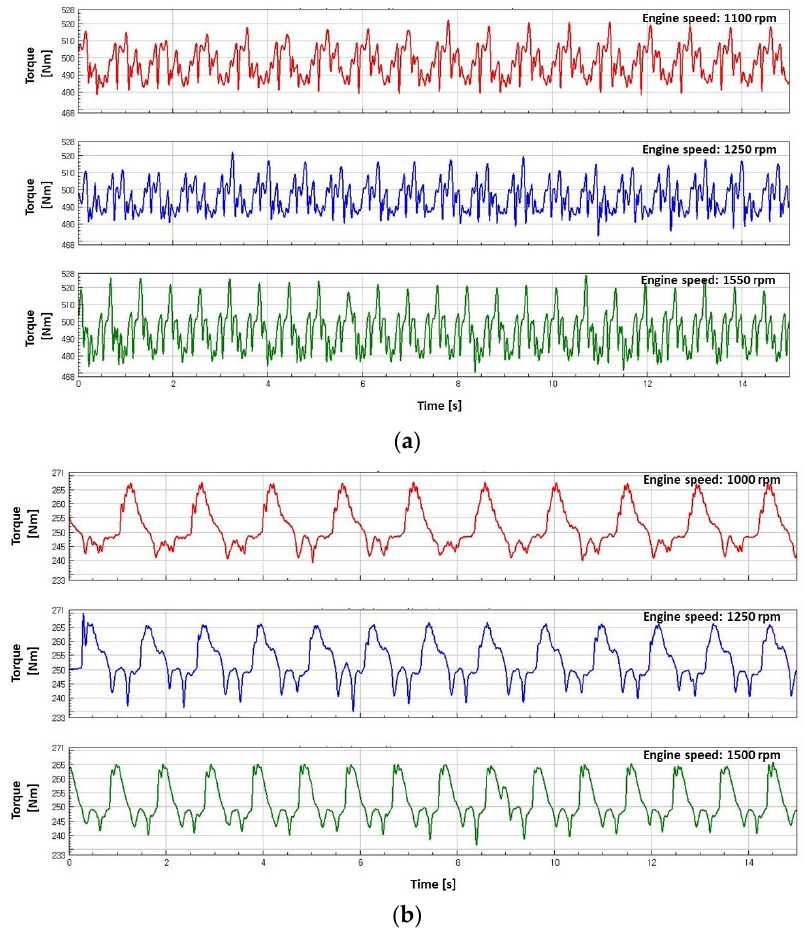
Figure 11. Measured torque of transplanting device input shaft at a planting distance of 0.35 m: ( a ) cam and ( b ) four-bar-link types.